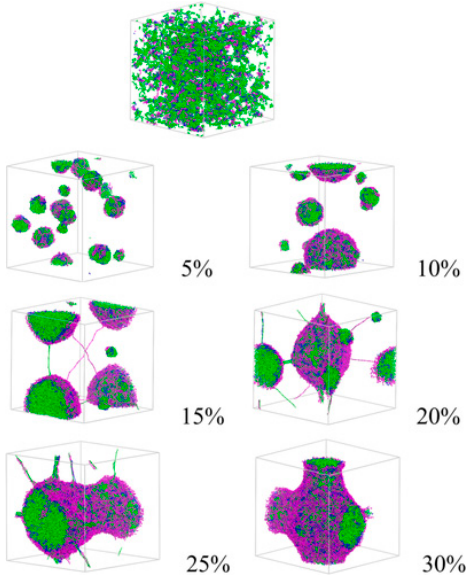
Figure 2. Morphology of PLGA–PEG–PLGA in water at different concentrations revealed by DPD simulation. Reprinted from Journal of Applied Polymer Science, 132, Yang Cao et al., In Vitro evaluation and dissipative particle dynamics simulation of PLGA–PEG–PLGA, 41280, Copyright (2014), with permission from Wiley.